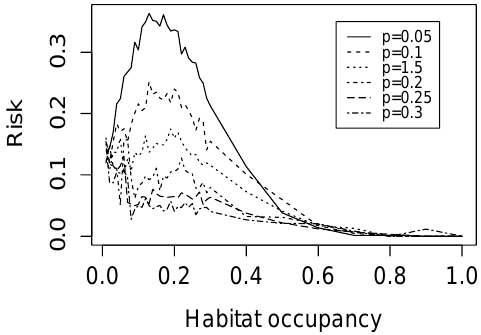
Figure 3. Lyme disease (LD) risk of simulated landscapes. Predicted LD risk as a function of habitat occupancy (forest cover). Each curve is evaluated for a landscape with a different percolation probability p .